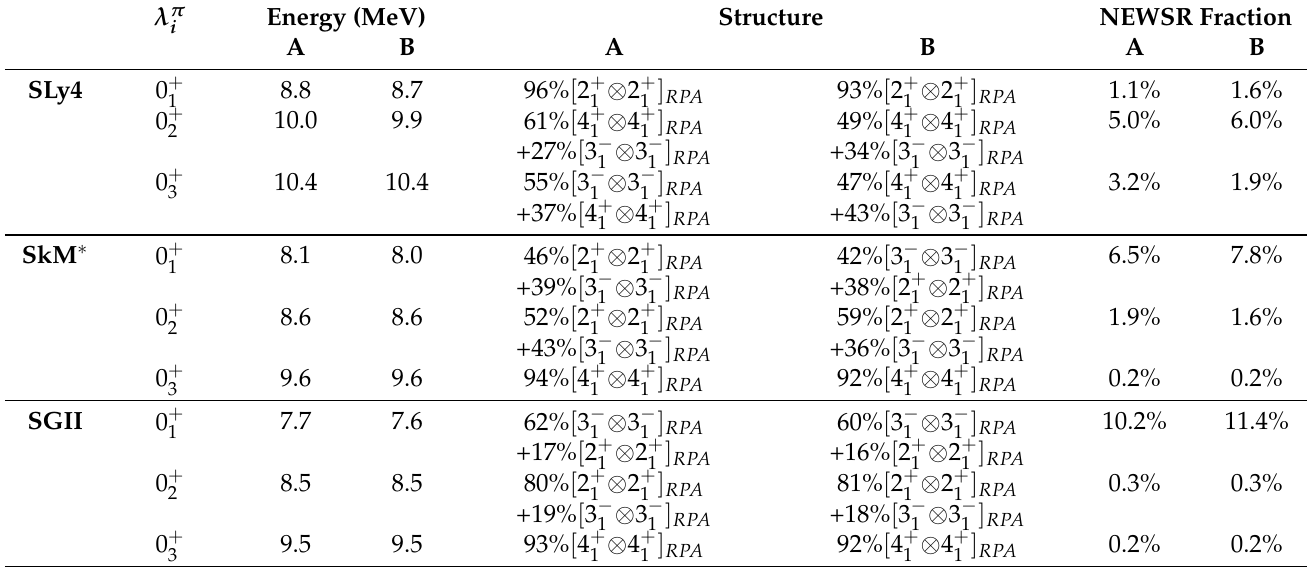
Table 3. Energies, dominant RPA components of phonon structures, and NEWSR fraction of the LTP 0 + states of 132 Sn using the Skyrme forces SLy4, SGII, and SkM ∗ . Columns ( A ) and ( B ) give the values calculated in the space of all the one- and two-phonon configurations with energies up to 25 MeV and 30 MeV,